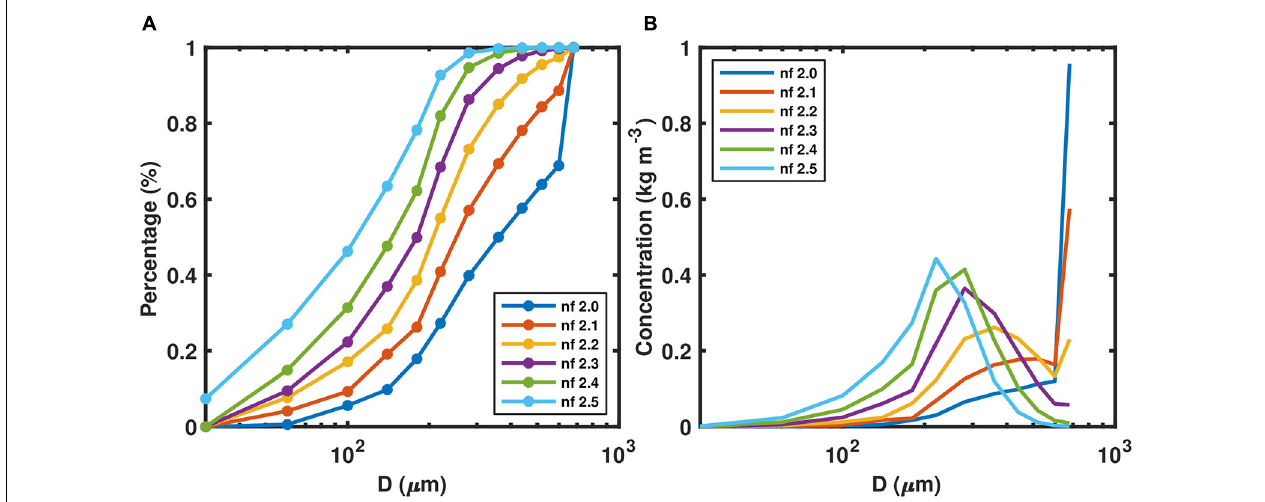
FIGURE 5 | Size distributions of OPA calculated at the end of 2 h simulation using different fractal dimensions (see legend). A collision efficiency of 0.3 was used for these simulations. (A) The cumulative distribution by % of the number of particles. (B) Size distribution by mass